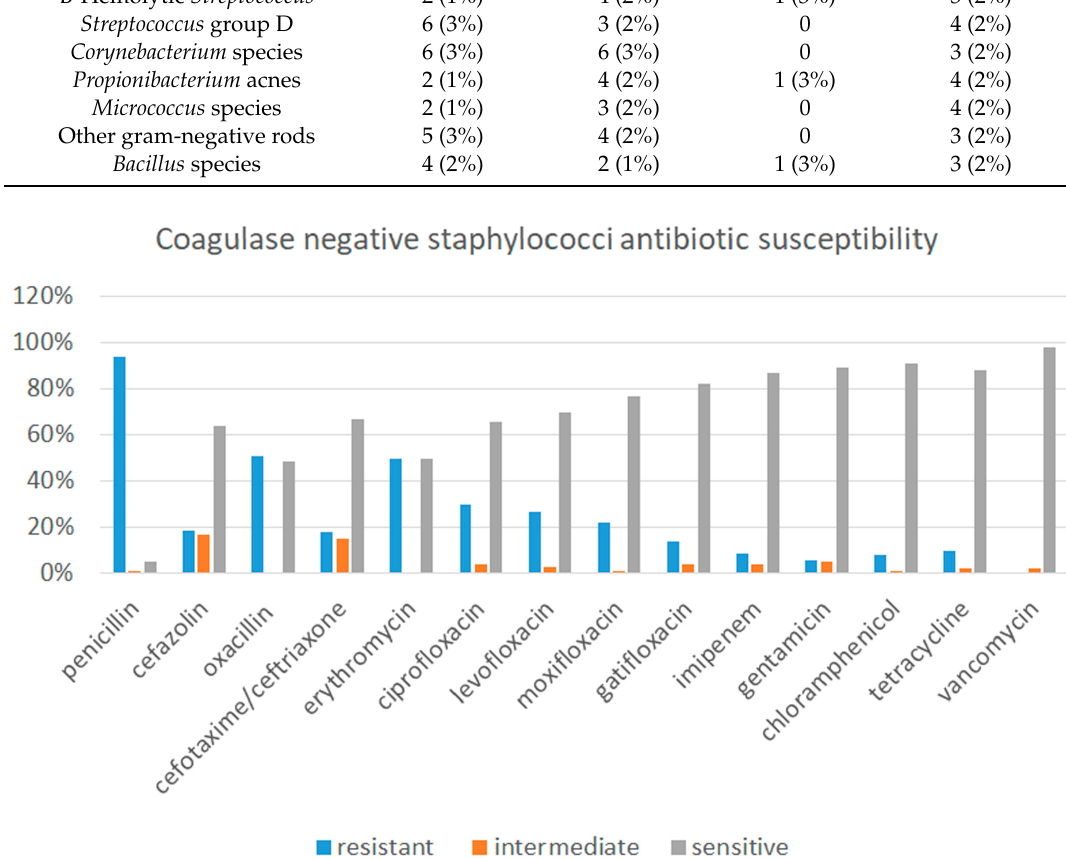
Table 3. Isolated bacteria from the conjunctival swab.